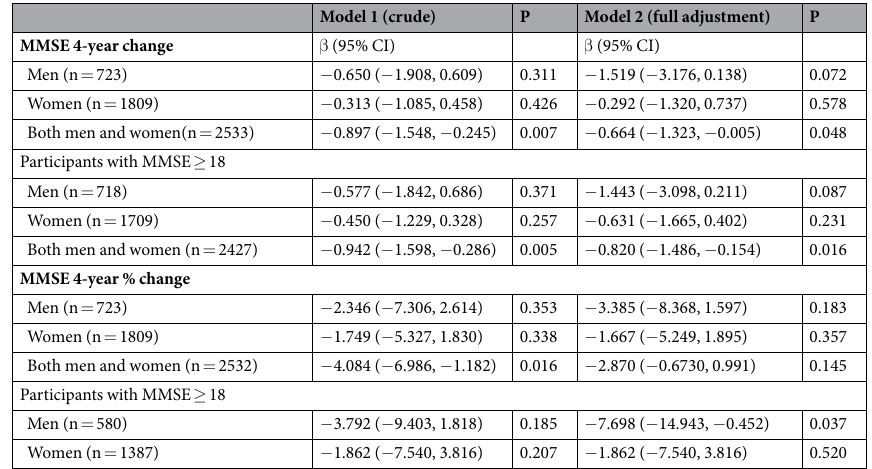
Table 2. Multivariable linear regression analyses between dietary acrylamide intake and changes of MMSE at the 4 th year follow-up among Chinese elderly men and women. Dietary acrylamide intakes were log 10 transformed. Multivariable linear regression models were adjusted for age (y), sex (not included for gender specific analysis), education, income, physical activity (PASE total scores), body mass index (kg/m 2 ), medical history of hypertension (yes/no), diabetes (yes/no), and coronary heart disease (CHD) (yes/no), dietary intake of carbonhydrate (g %kcal), fish (g/week), fruit and vegetables (g/1000 kcal), fiber (g/d) and isoflavones (mg/d), alcohol drinking (g/day), tea drinking (ml/wk), total AHA scores. Total AHA scores were estimated based on the adherence index of American Heart Association on dietary and life style recommendations. MMSE: questionnaire for Mini-Mental State